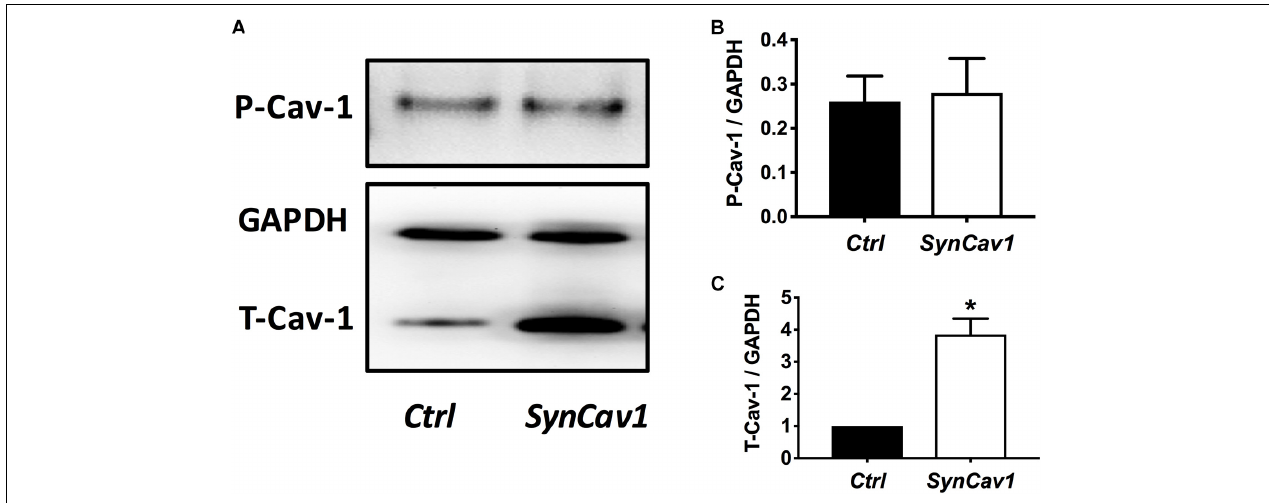
FIGURE 4 | SynCav1 increases T-Cav-1 but not P-Cav-1 in NPCs. (A) NPCs were treated with SynCav1 (2 × 10 9 IU/ µ l) for 72 hours followed by Western blot for P-Cav-1, T-Cav-1, and GAPH. Quantitation for P-Cav-1 and T-Cav-1 are shown in (B , C) , respectively. Data are expressed as mean S.E ( n = 3, ∗ p < 0.05, t